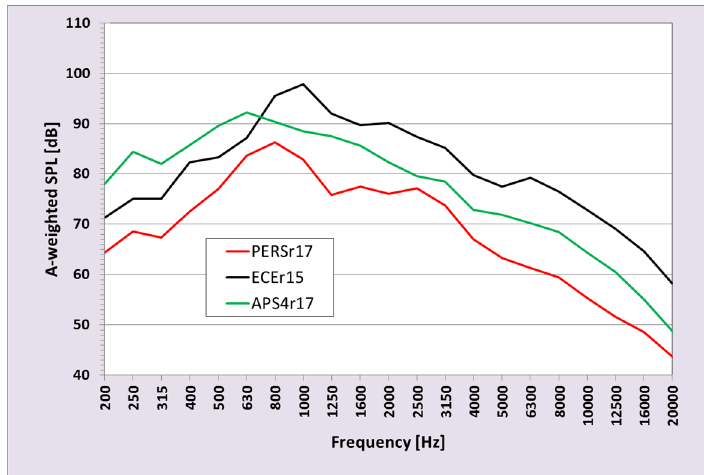
Figure 2. Comparison of spectra for tire T1064 at speed 80 km/h (PERS is the PERS ‐ HET ‐ type (slabs produced by HET)).